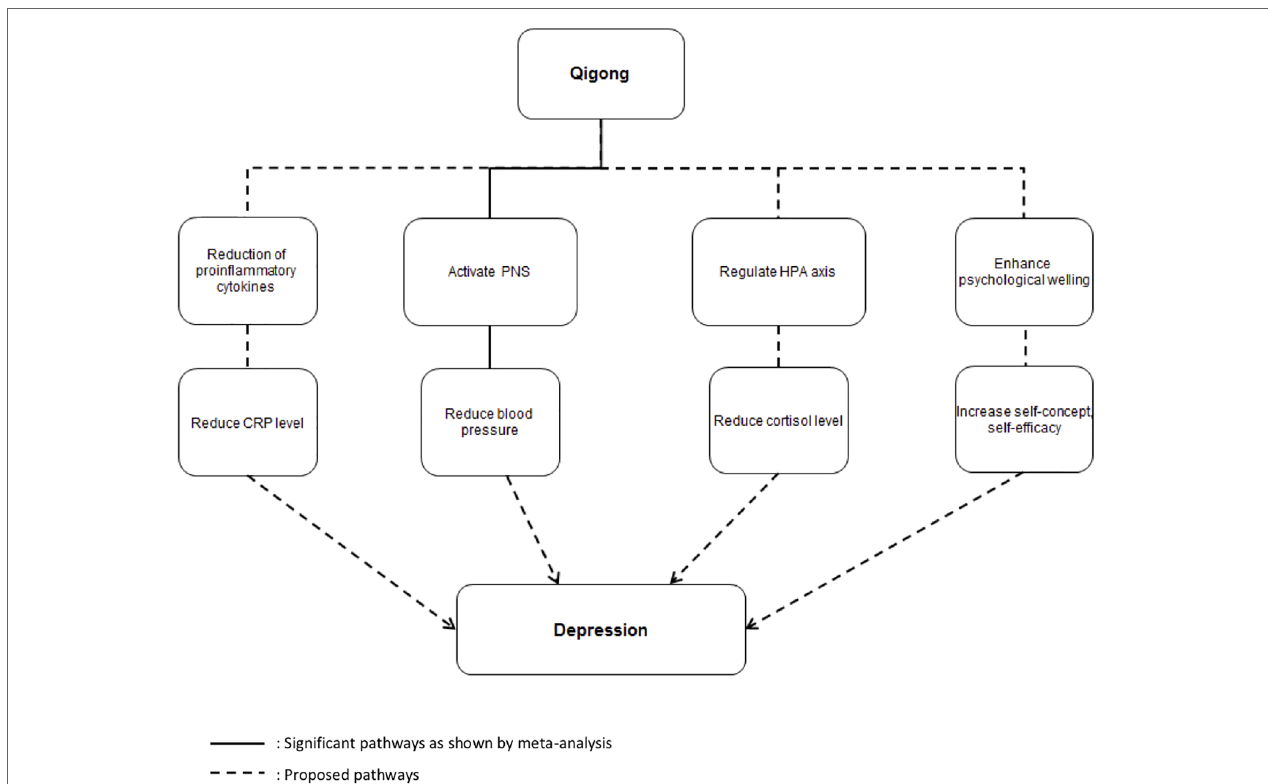
FiGURe 6 | Summary of possible anti-depressive mechanisms of qigong. Solid lines indicate significant pathways as shown by meta-analysis. Broken lines indicate the proposed pathways.